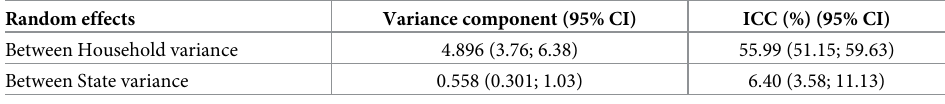
Table 2. Null model–model with intercept only and random effects (state and